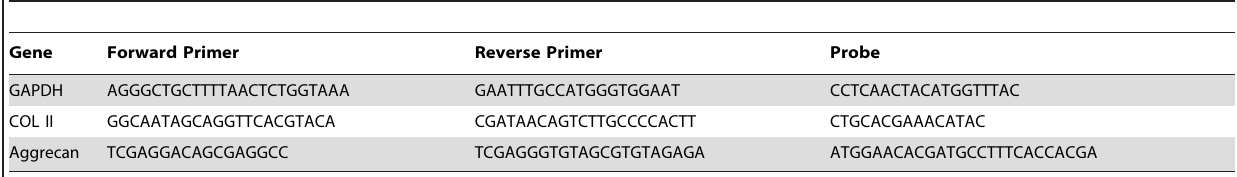
Table 1. Sequences of primers and probes used for Real-Time PCR. Sequences related to gene type X collagen and MMP13 are proprietary to Applied Biosystems Inc. and not